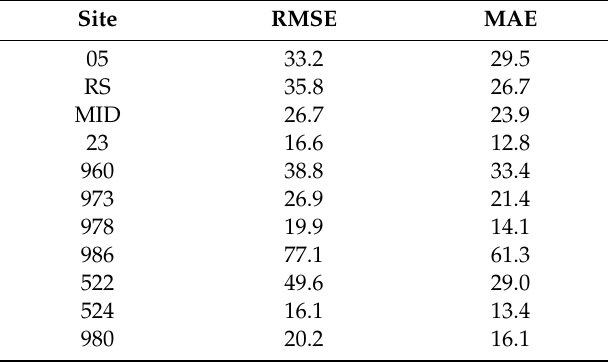
Table 4. Skill scores of hourly forecasts for wind direction ( ◦ ) at di ff erent locations of the Madeira Island. Site RMSE MAE 05 33.2 29.5 RS 35.8 26.7